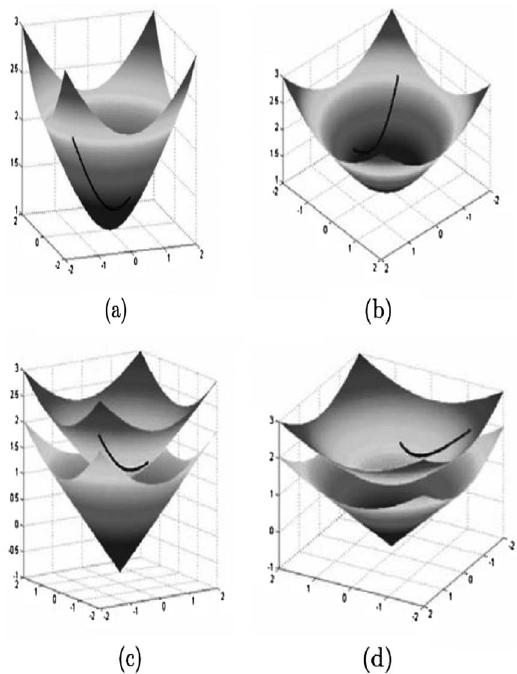
Figure 5. The shapes of interpolation are simulated with MATLAB Programming Language. (a) The interpolation curve between two split quaternion on hyperbolic sphere in Minkowski space, there are 50 interpolated frames, (b) inside scope, (c) outside scope, (d) inside scope